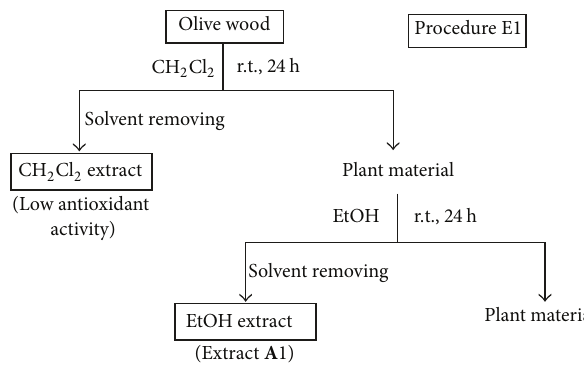
Figure 1: Solvent extractions of olive wood sample A following procedure